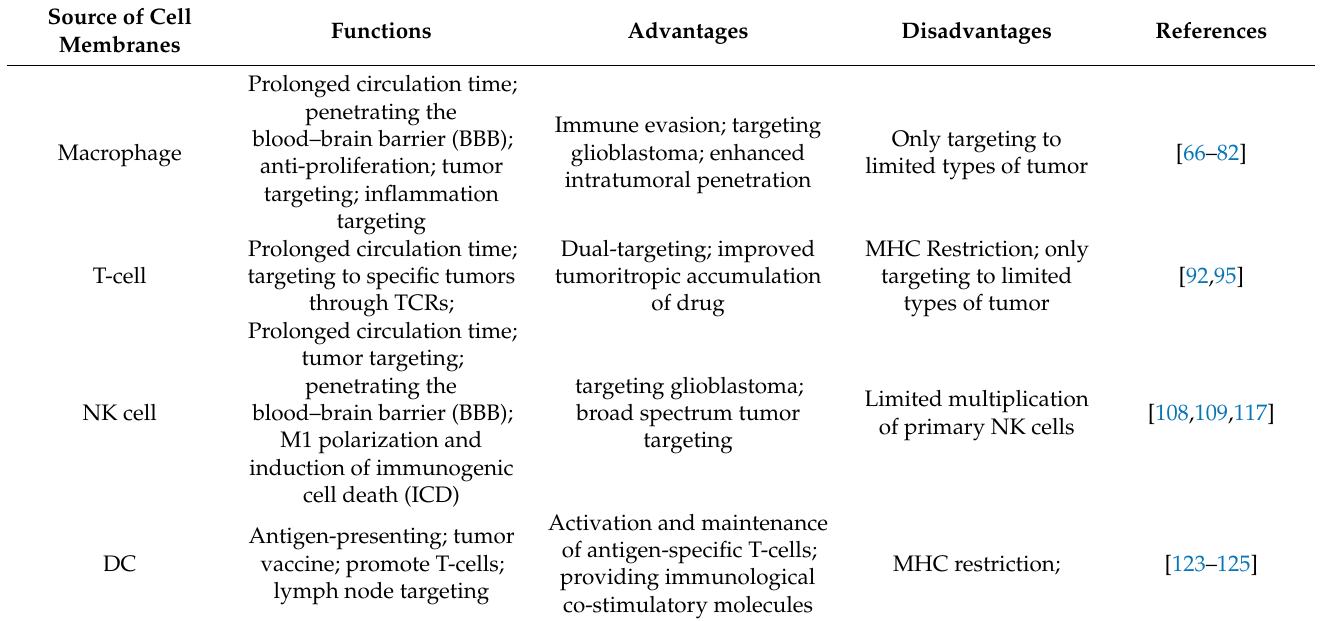
Table 2. The functions, advantages and disadvantages of different immunocyte membrane-coated nanoparticles. Source of Cell Membranes